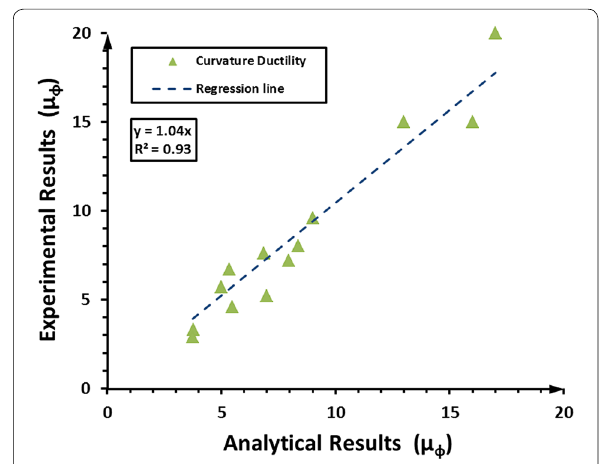
Fig. 8 Comparison of experimental and analytical